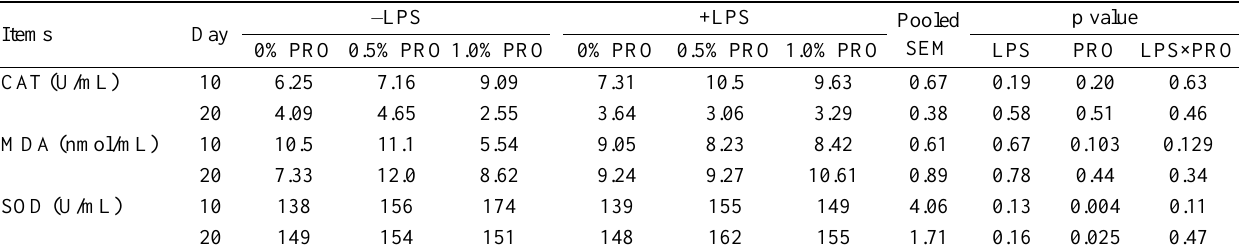
Table 5. Effects of L-proline supplementation on MDA content and activities of CAT and SOD of weanling piglets after LPS challenge (10-20 d) 1